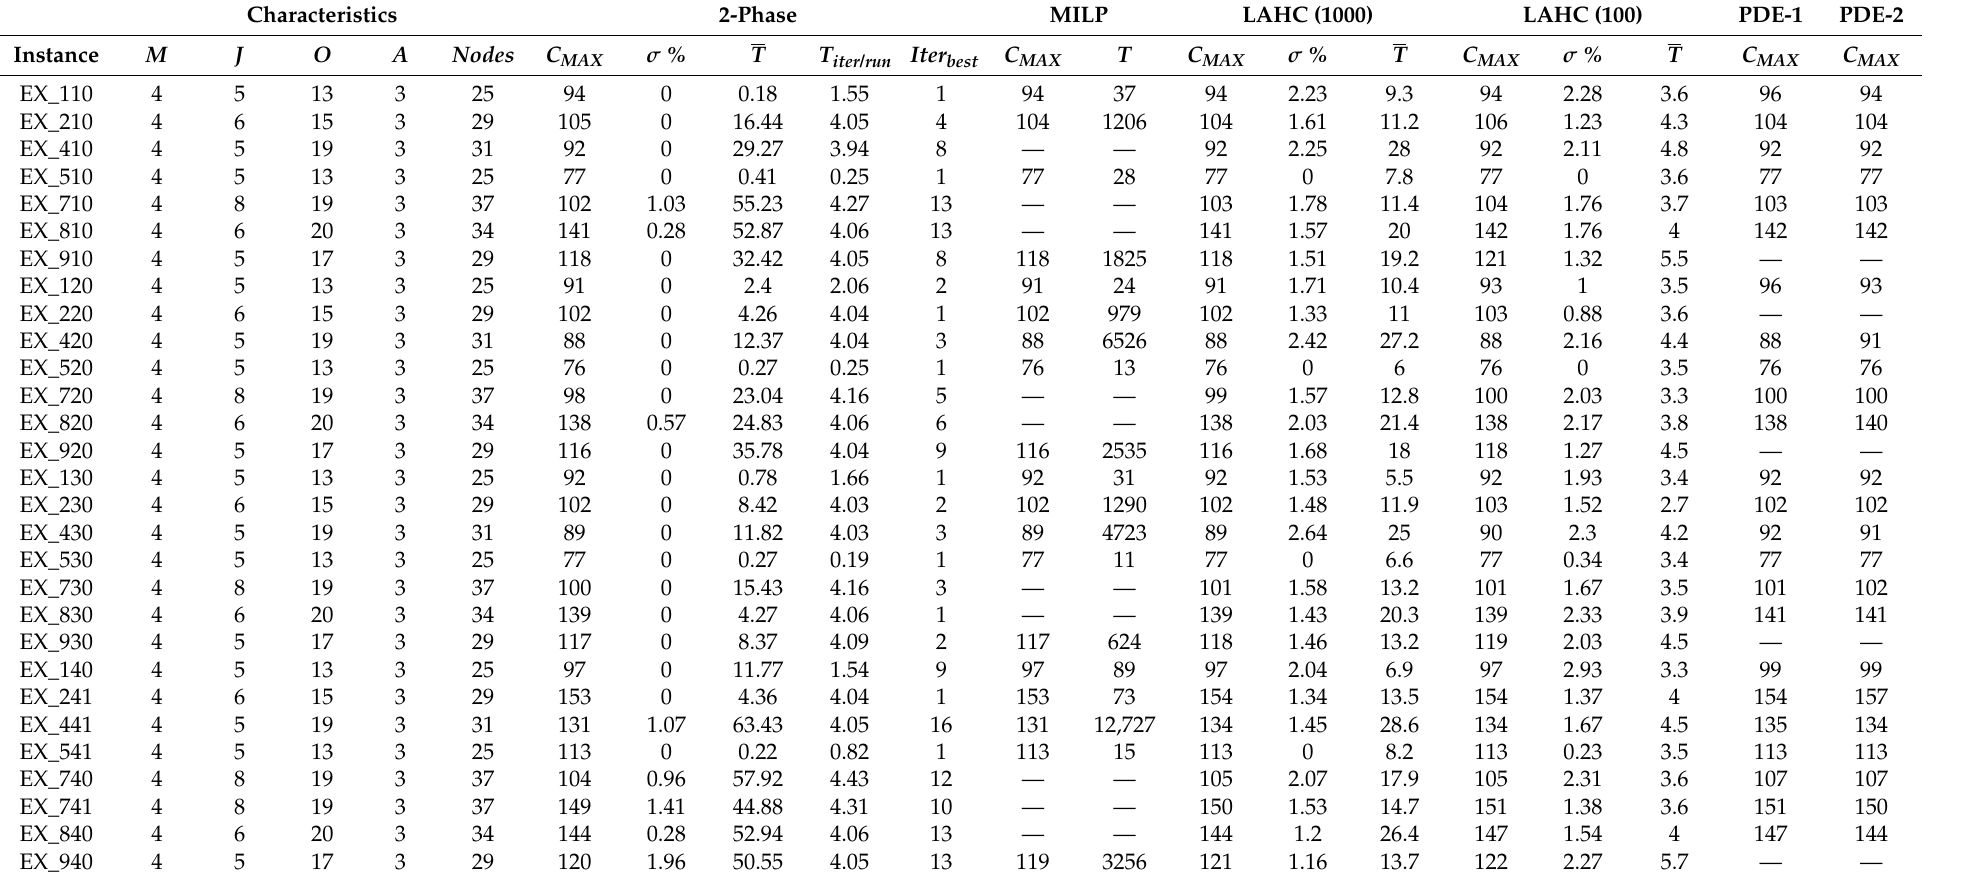
Table 4. Performance comparison of two-phase heuristic with existing approaches on Kumar, Janardhana and Rao [11] test instances with ratio less than 0.25.